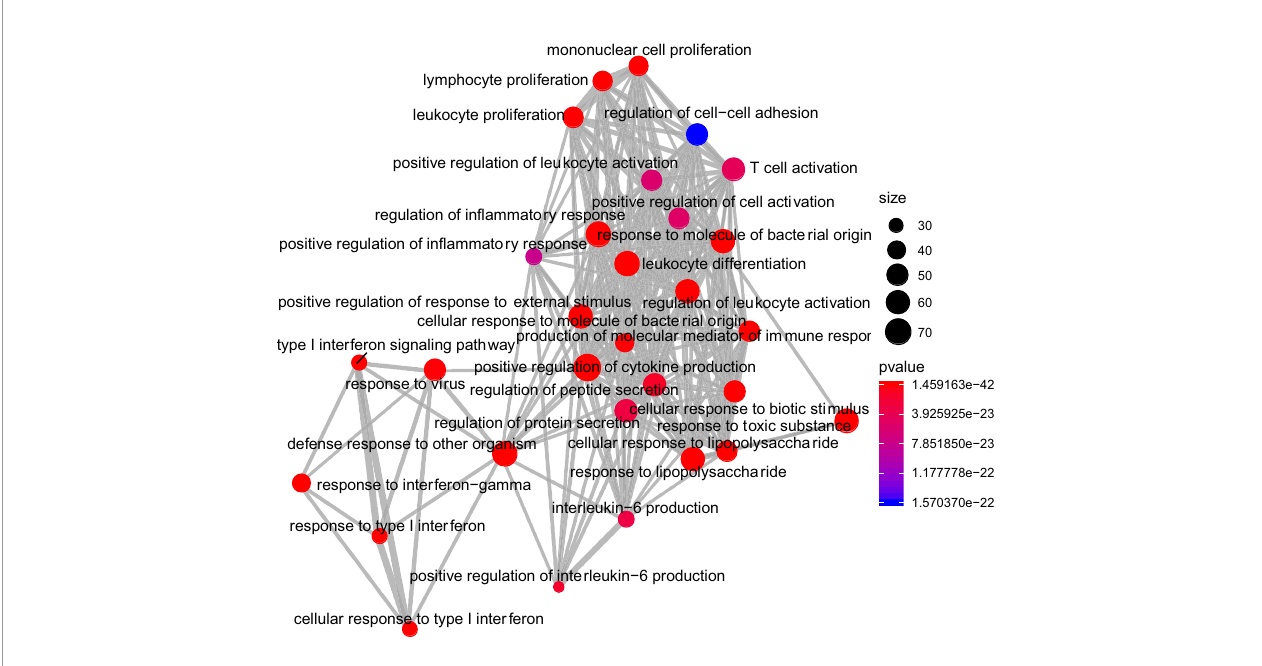
FIGURE 4 | Network of enrichment analysis of GO biological process terms. The size of the node represents the number of genes involved in the enrichment pathway, and the color from blue to red indicates the P-value from small to large.